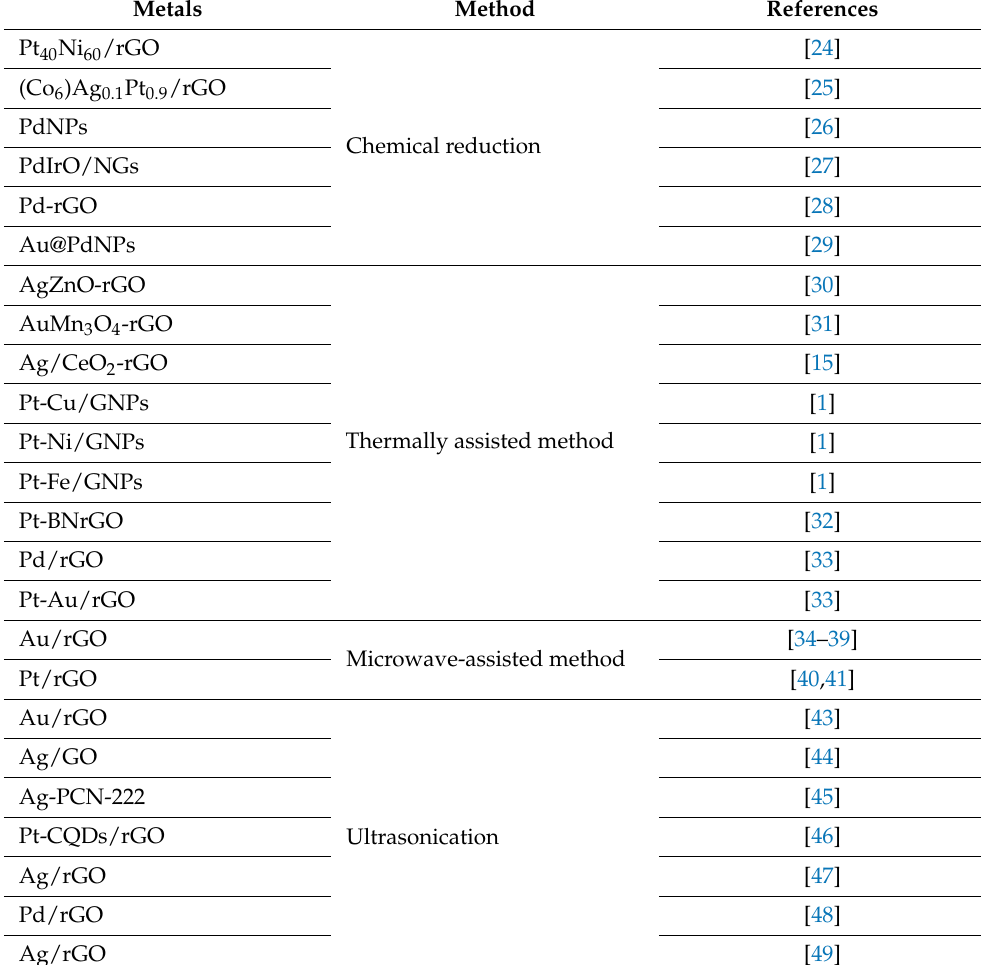
Table 1. Synthesis method depending on the nature of the introduced metal.